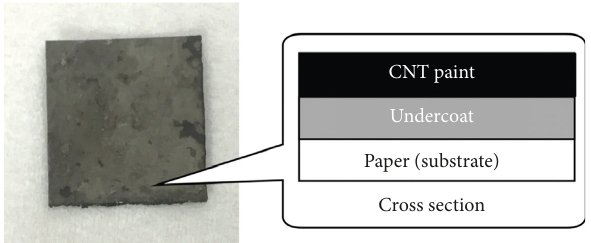
Figure 4: Modified semiconducting electrode with undercoat using conductive silver paste.